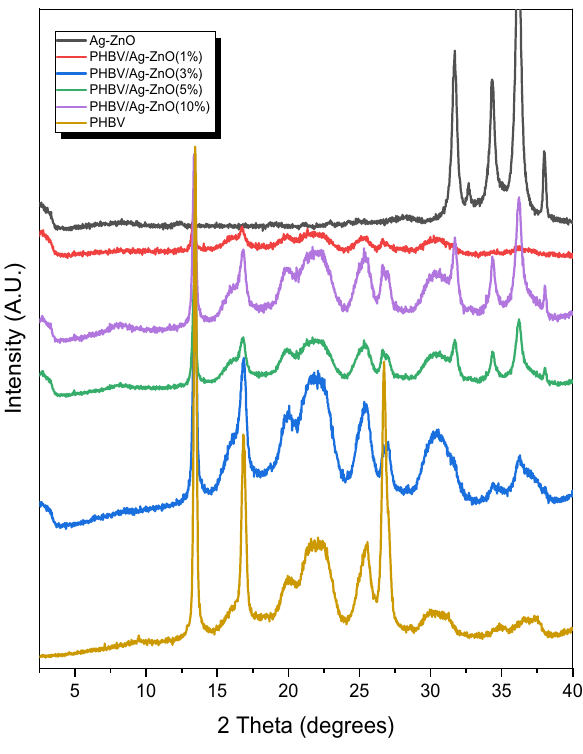
Figure 4. XRD spectra Ag–ZnO, PHBV and PHBV/Ag–ZnO (1, 3, 5, 10%) bionanocomposites.